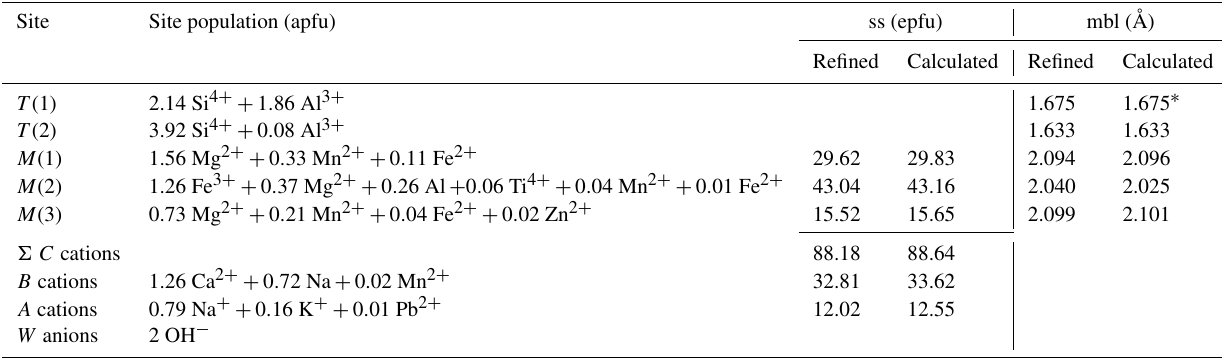
Table 7. Site occupancies for ferri-taramite with site scattering (ss) and mean bond lengths (mbl’s).